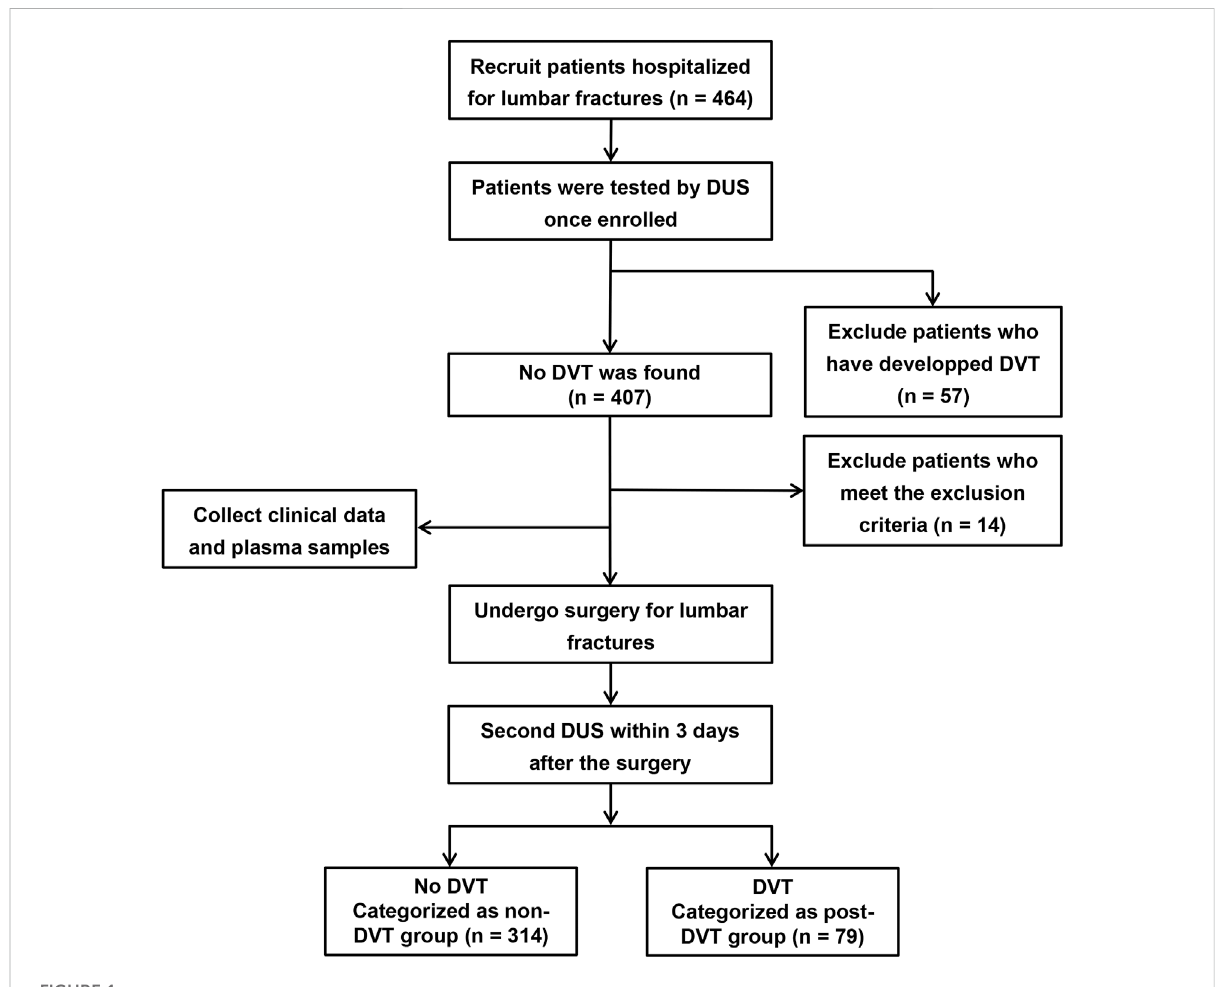
FIGURE 1 Flow chart of classi fi cation of non-DVT and post-DVT groups.